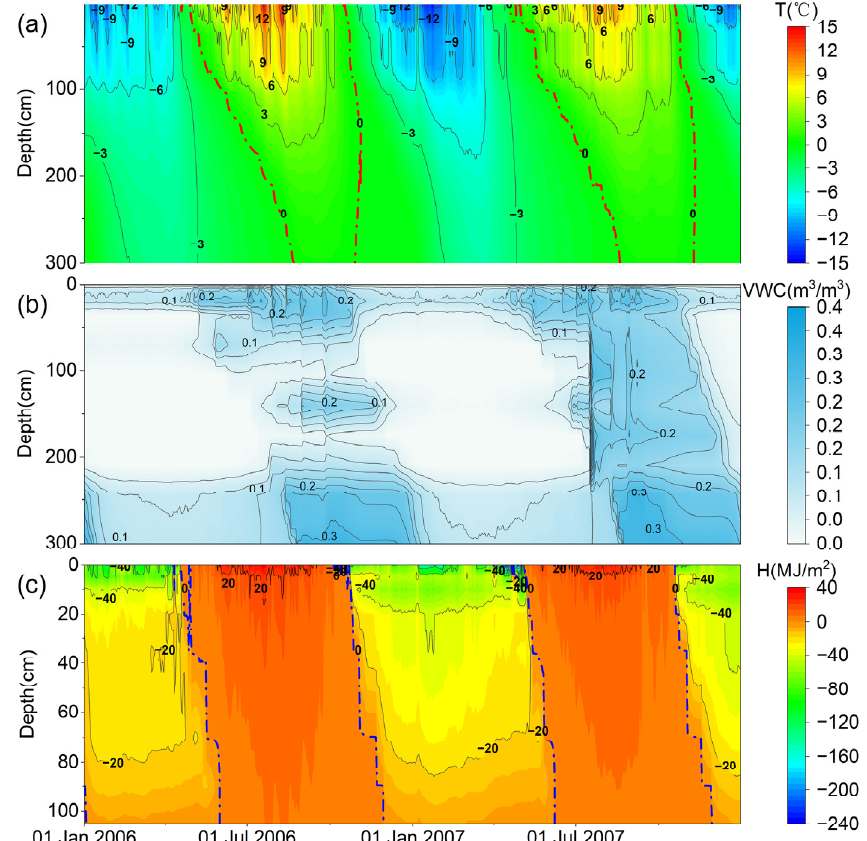
Figure 5. The variations in ( a ) the observed soil temperature, ( b ) the observed soil moisture, and ( c ) simulated soil enthalpy at various depths during the period of 1 January 2006 to 31 December 2007 at the TGL